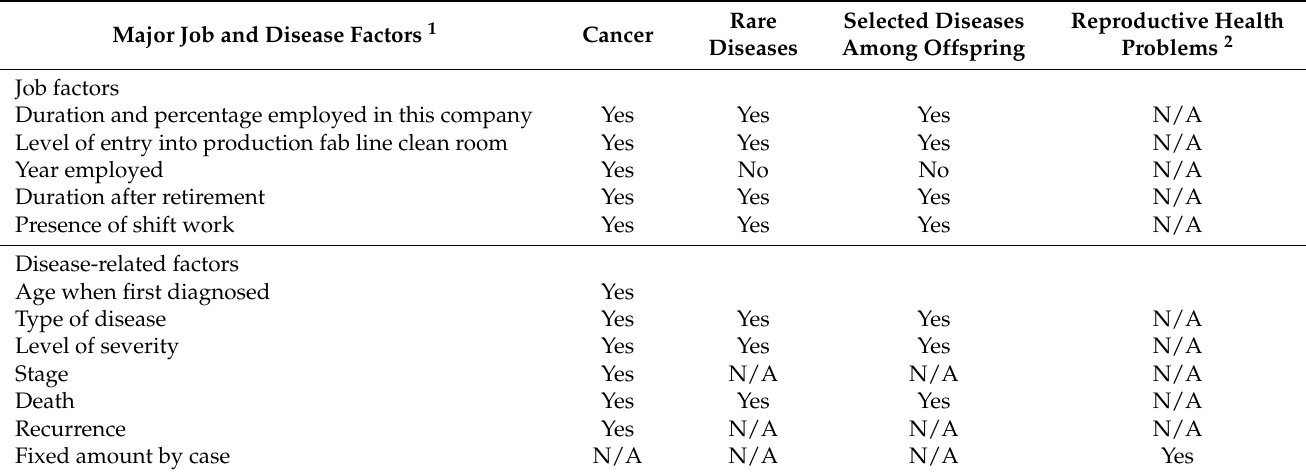
Table 5. Major occupational and disease-related factors to calculate total financial support compensa- tion